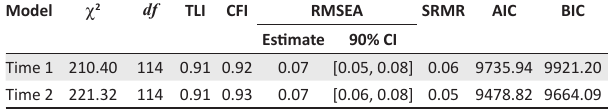
TABLE 3: Measurement model fit statistics for workplace